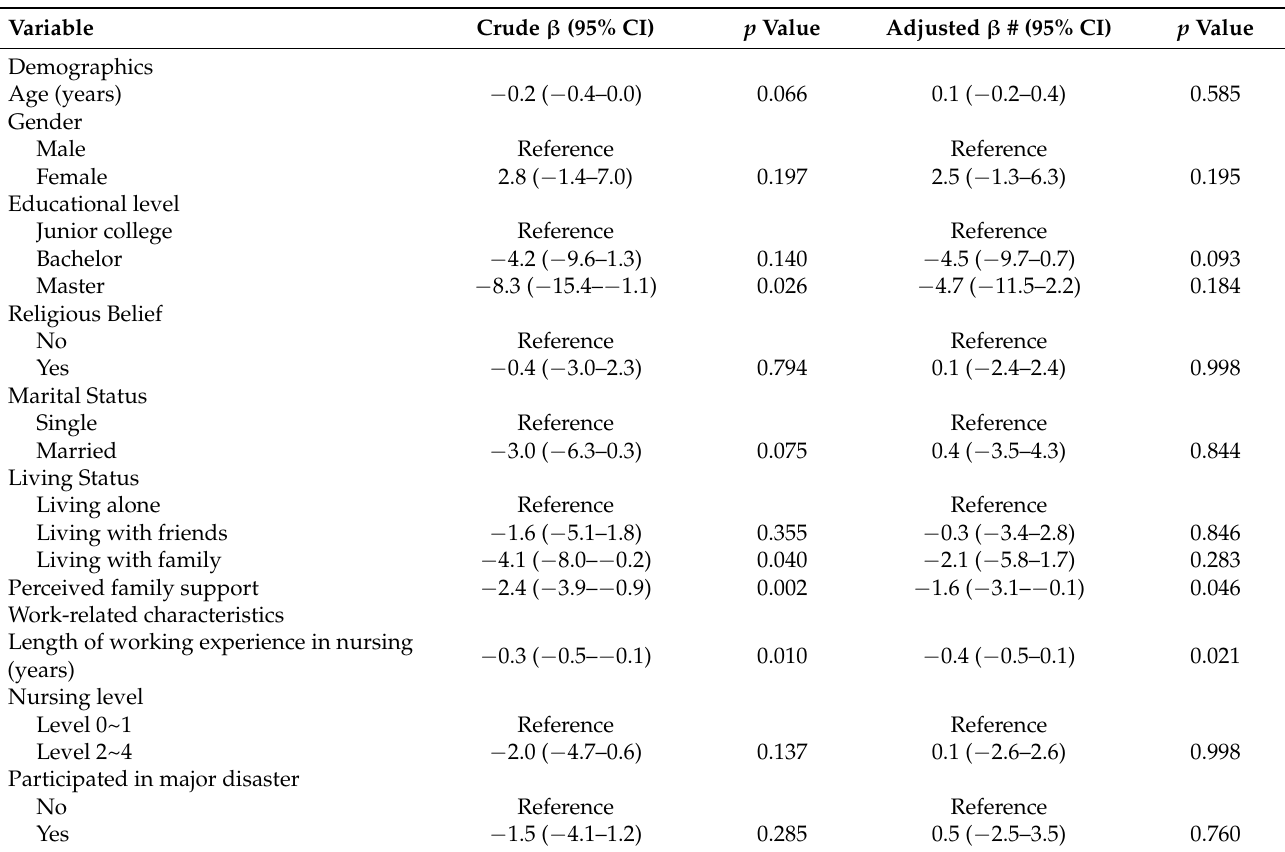
Table 3. Predictors of perceived stress among critical care nurses caring for critical patients with COVID-19 ( n =